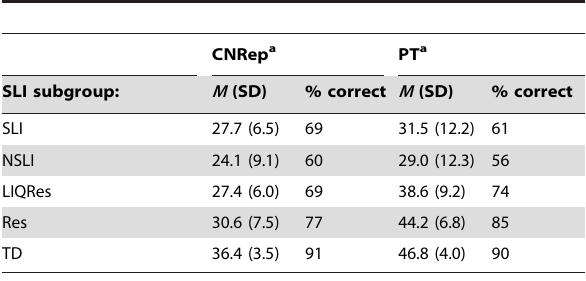
Table 2. Memory and morphology scores for subgroups of children with a history of SLI and TD